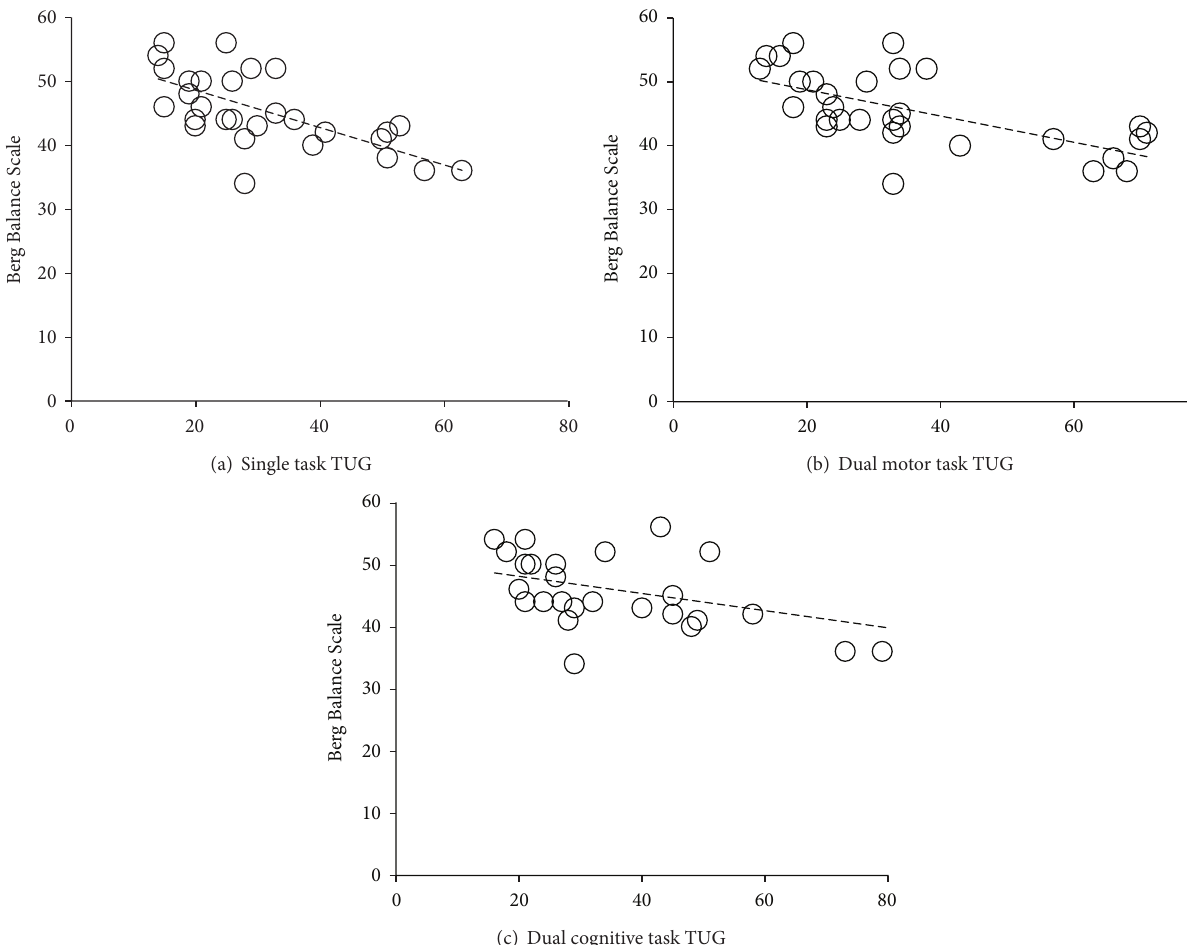
Figure 3: Scatter plots between Berg Balance Scale (BBS) scores and time to complete Timed Up and Go (TUG) test across three attentional loading conditions. (a) Single task TUG, (b) dual motor task TUG, and (c) dual cognitive task